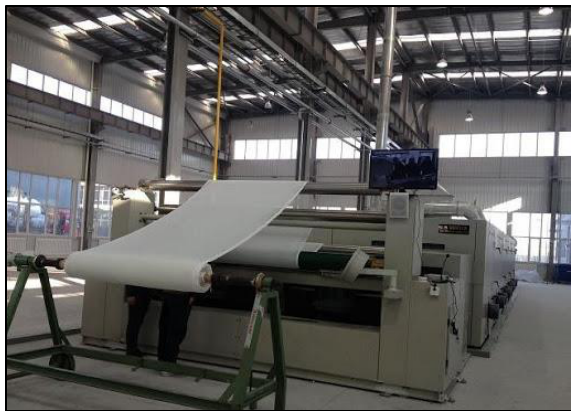
Fig. 2. Heat setting is carried out with stenter